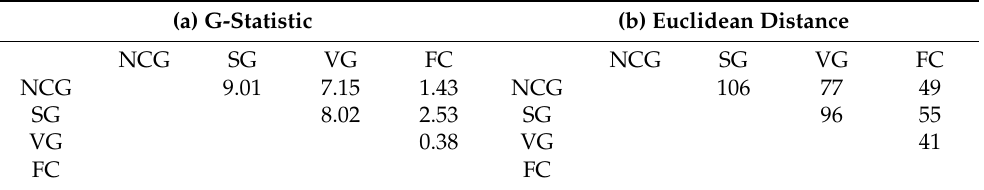
Table 2. Similarity of texture features calculated by (a) G-statistic and (b) Euclidean distance. NCG— newly created gap, SG—shaded gap, VG—vegetated gap, and FC—forest